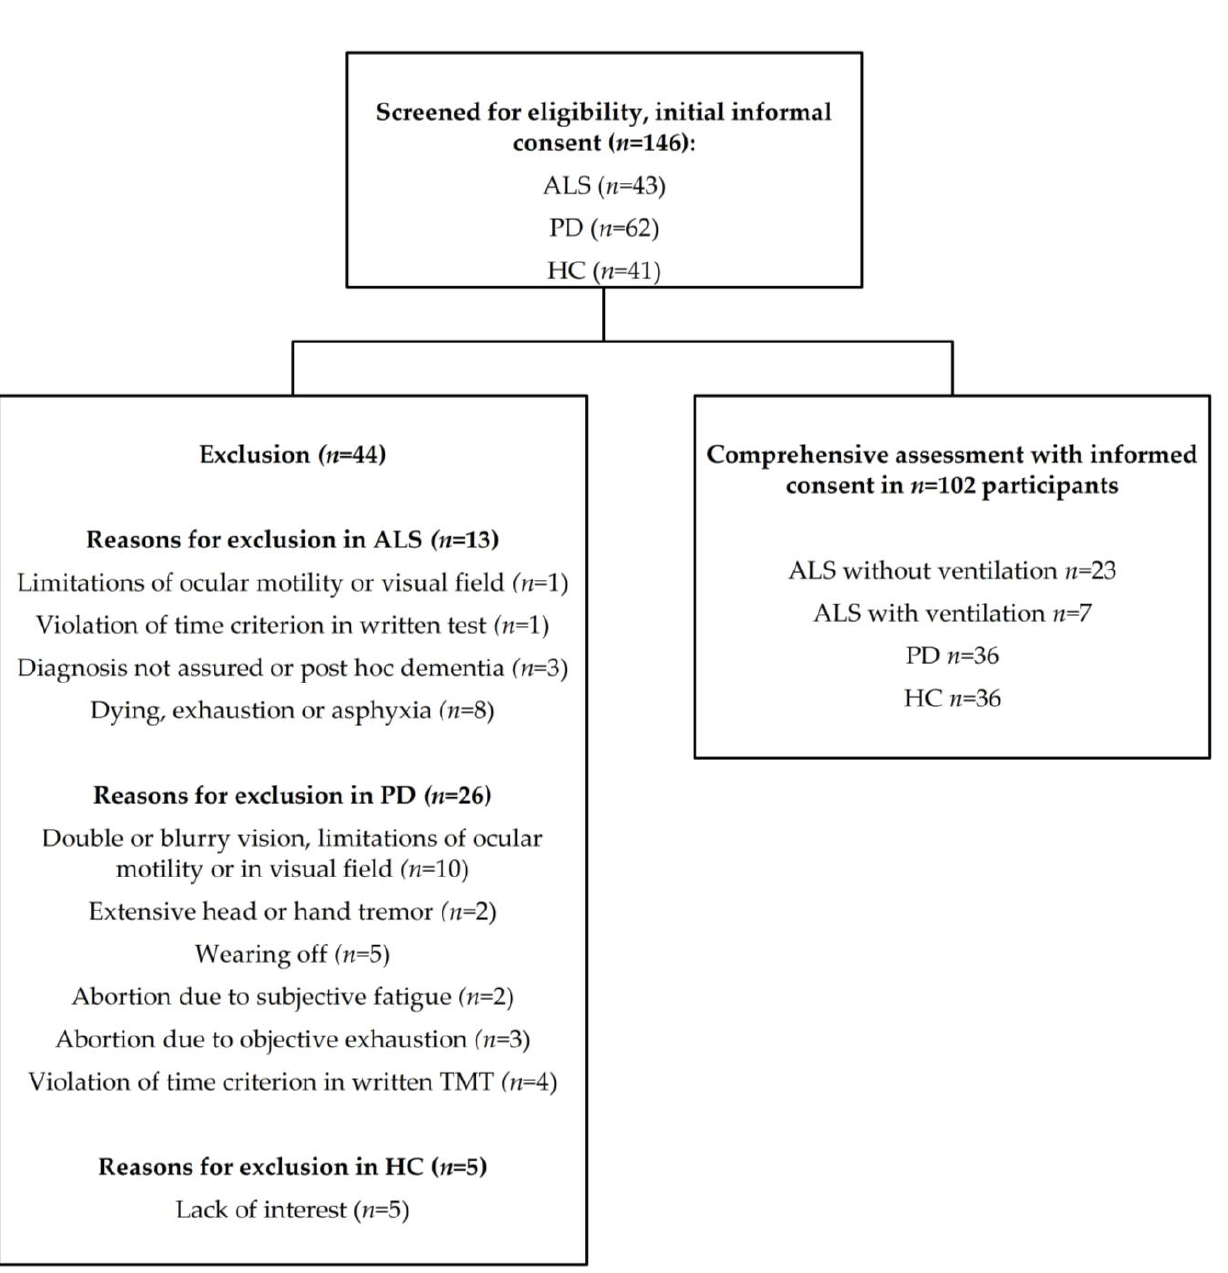
Figure 1. Flowchart of study enrollment for patients and healthy controls (HC).